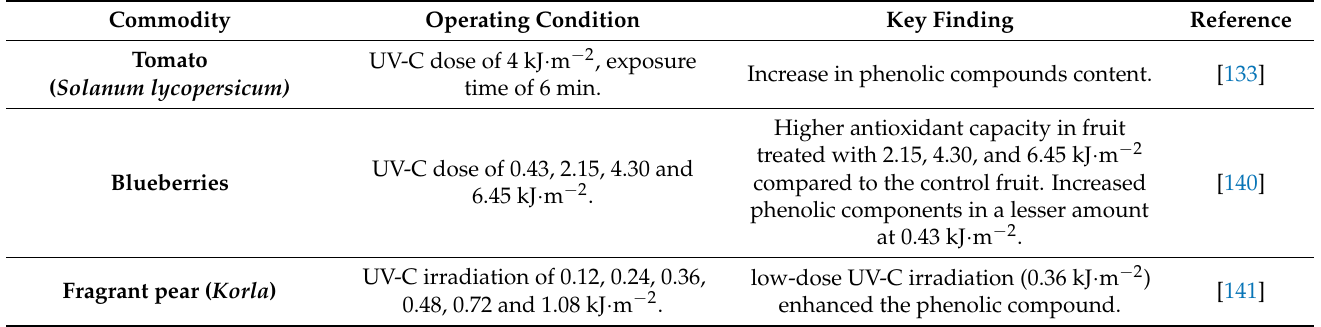
Figure 2. Diagrammatic representation for stress response as a result of low and high UV-C hermosis effect. The physiological modification encountered gives rise to changes in mechanical and other attributes of the vegetable. Table 2. Different horticultural product’s metabolic activities when subjected to a varied UV-C dose and other operational